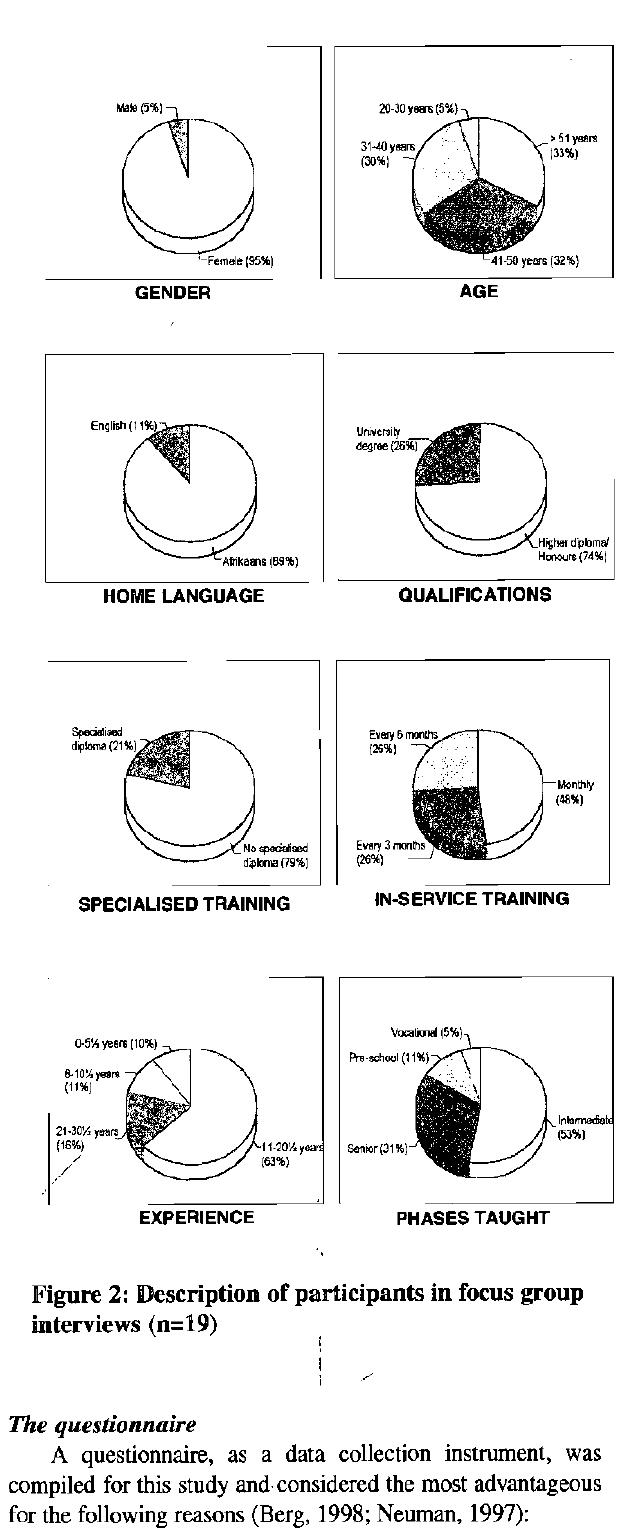
Figure 2: Description of participants in focus group interviews